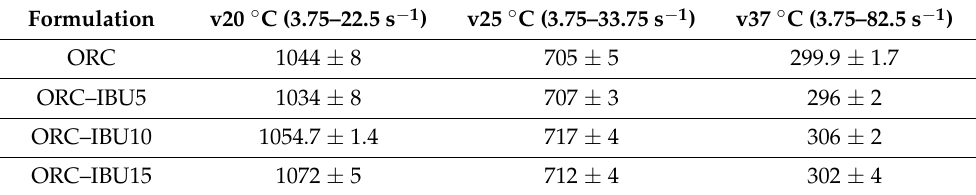
Table 4. Summary of viscosities measured in ORC and ORC–IBU solutions. Means ± sd, n = 4, 8, 18 (respectively at 20, 25 and 37 ◦